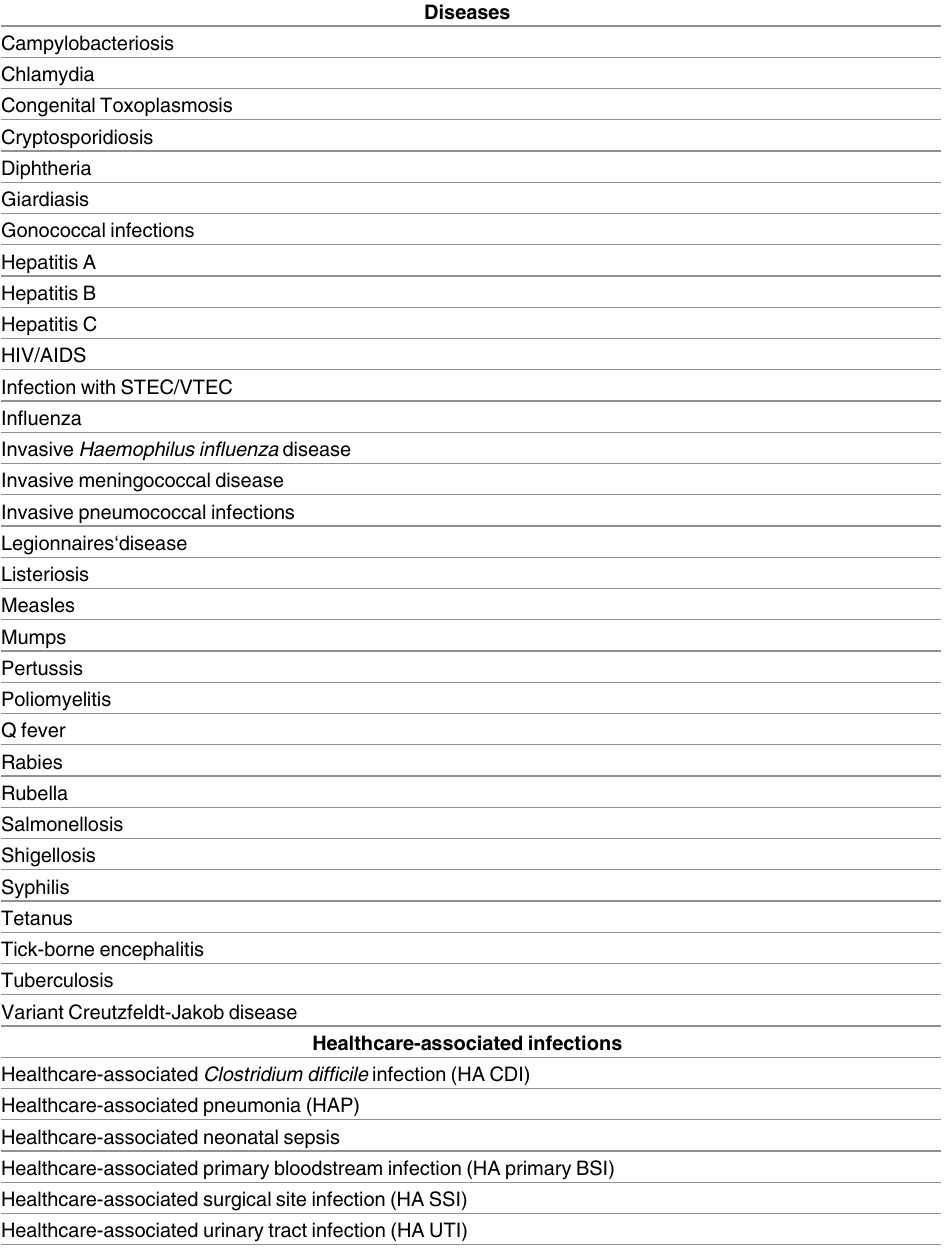
Table 1. Diseasesand healthcare-associated infections included in the BCoDE toolkit for DALYs